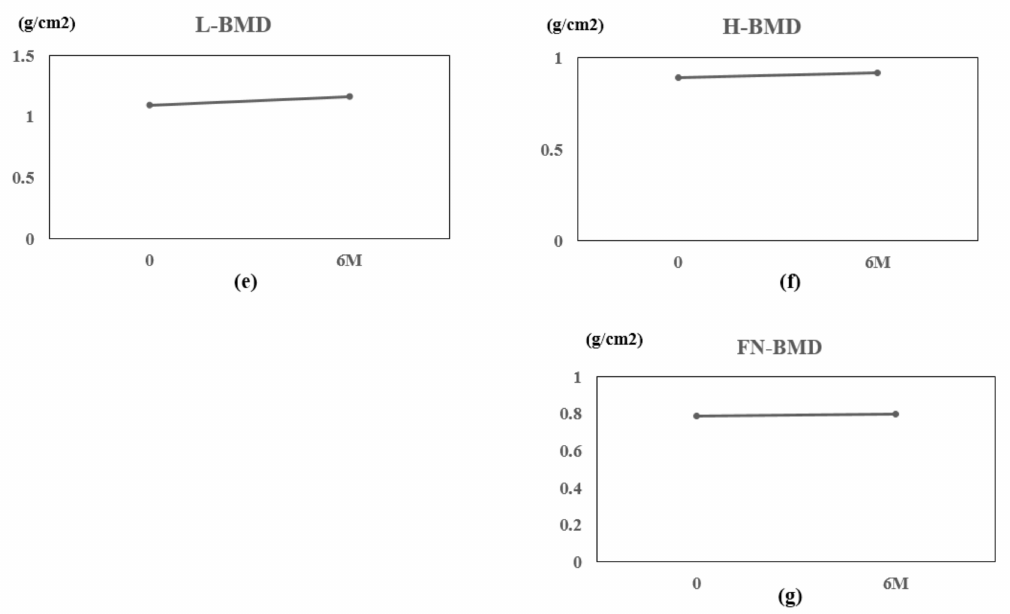
Figure 1. Patient 1 data: Value changes in bone alkaline phosphatase (BAP) ( a ), type I procollagen N-terminal propeptide (total P1NP) ( b ), urinary N-terminal telopeptide of type-I collagen (urinary NTX) ( c ), and tartrate-resistant acid phosphatase (TRACP)-5b ( d ), before and after one week (W) and one, two, four, and six months (M) of denosumab therapy. Value changes in lumbar 1–4 bone mineral density (L-BMD) ( e ), total hip BMD (H-BMD) ( f ), and femoral neck BMD (FN-BMD) ( g ) before and